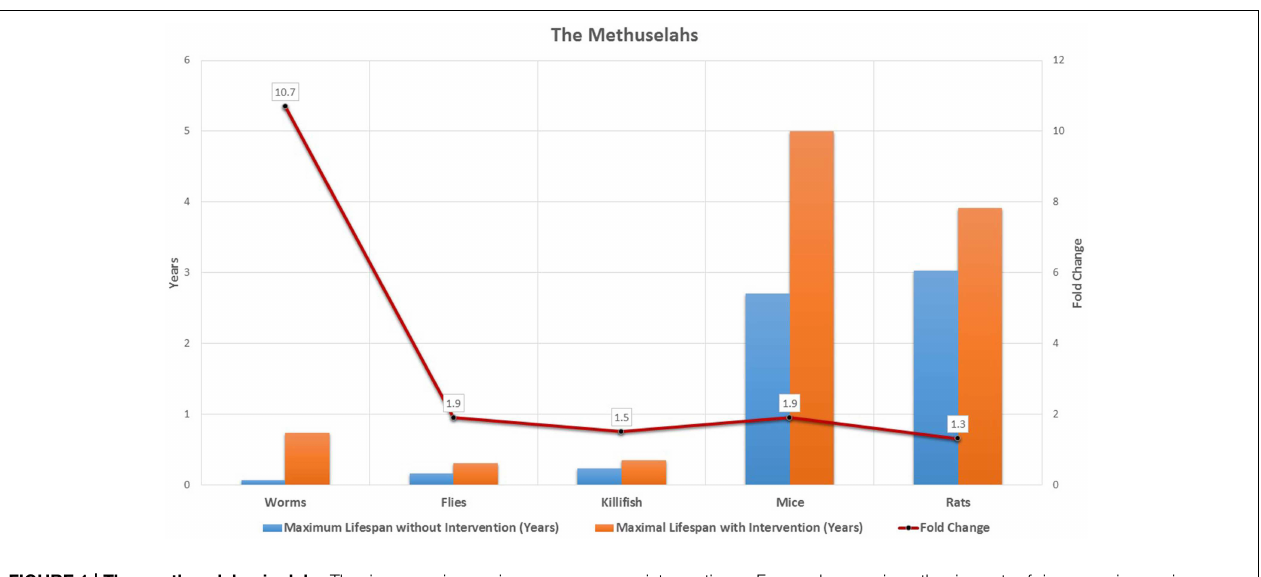
interventions. For each organism the impact of increase in maximum lifespan through intervention is indicated in the graph using fold